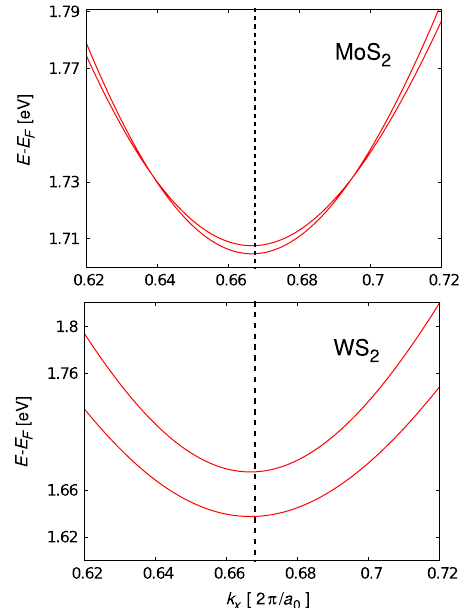
FIG. 3 Upper panel: Spin-split DFT CB of MoS 2 in the vicinity of the K point, which is indicated by a vertical dashed line. Lower panel: The same for WS 2 . A band crossing, which can be seen in the case of MoS 2 , is absent for WS 2 . The small asymmetry in the figures with respect to the K point, especially in the case of the band-crossing points in the upper panel, is due to the fact that the calculations were performed along the Γ KM